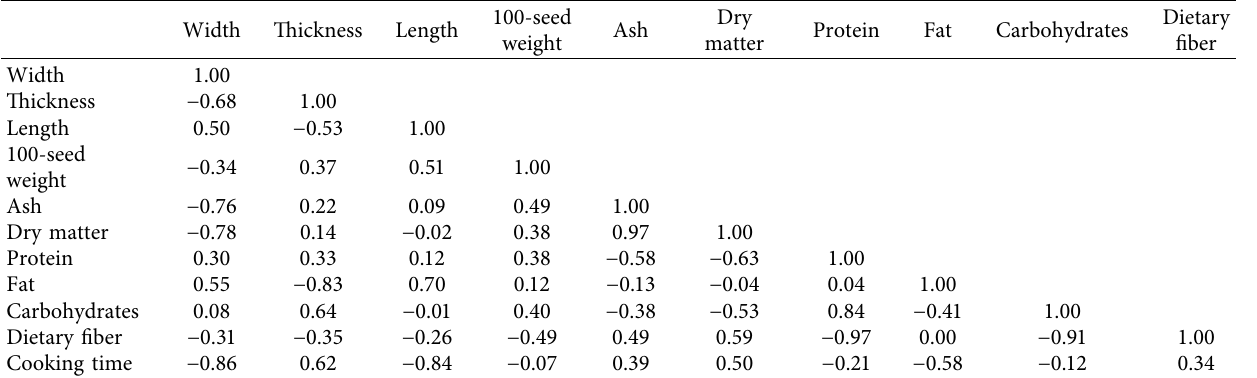
Table 6: Correlation matrices between Kersting’s groundnut physical characteristics and proximate composition.